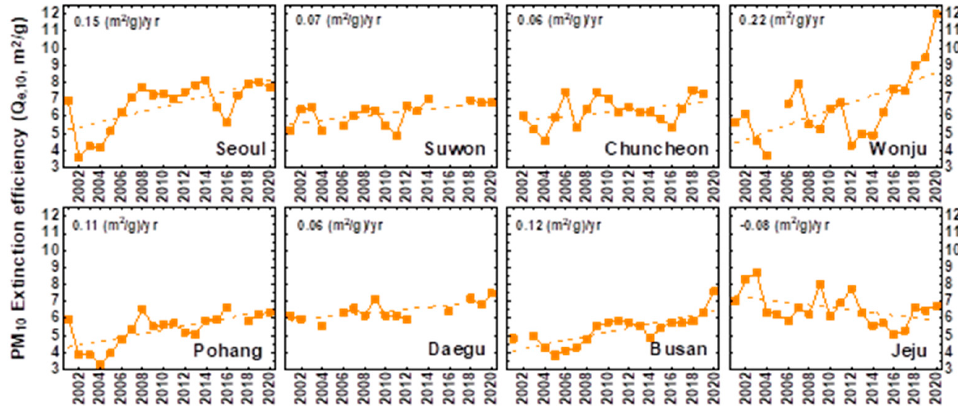
Figure 4. Q e,10 annual average and trend 2001–2020. Wonju Q e,10 had an increasing trend of 0.22 (m 2 /g)/yr, the steepest increase among the eight cities. Q e,10 in 2012 was 4.3 ± 2.3 m 2 /g, which was quite low, but it had a high value continuously since Q e,10 increased to 6.2 ± 6.4 m 2 /g in 2015. Seoul’s results, which had a high CL of 99%, have Q e,10 increasing at 0.15 (m 2 /g)/yr, which was the second steepest increase after Wonju. Seoul’s Q e,10 showed the highest value at 8.1 ± 4.1 m 2 /g in 2014, and then it showed a lower value again in 2015 (6.5 ± 3.0 m 2 /g) and 2016 (5.7 ± 2.5 m 2 /g). Seoul had a high Q e,10 again after 2017. Unlike the other seven cities, Jeju’s Q e,10 decreased to − 0.08 (m 2 /g)/yr, but the CL for the trend was less than 95%. The annual average mass extinction efficiency (Q e,2.5 ) of PM 2.5 , from 2015 to 2020, is shown in Figure 5, and the annual values are shown in Table 6. As shown in Table 1, the slope of Q e,2.5 in all cities showed an increasing trend. Table 3 presents the statistical Table 5. Q e,10 by city from 2001 to 2020. test results for this trend. The increasing Q e,2.5 trend in Wonju, Busan, and Jeju had a Q e,10 (m2/g) high CL of more than 95%. As for Q e,10 , Wonju had the steepest increasing trend with a Q e,2.5 slope of 2.47 (m 2 /g)/yr. In addition, except for Suwon and Pohang, where data are few, the city showing the steepest increase after Wonju was Chuncheon with a slope of 1.12 (m 2 /g)/yr. However, the slope of the increasing trend of Q e,2.5 in Chuncheon had a low CL of less than 95%. As can be seen in Figure 3, although PM 2.5 decreased in Wonju and Chuncheon, visibility did not improve, or even though there was no significant change in PM 2.5 , visibility deteriorated.